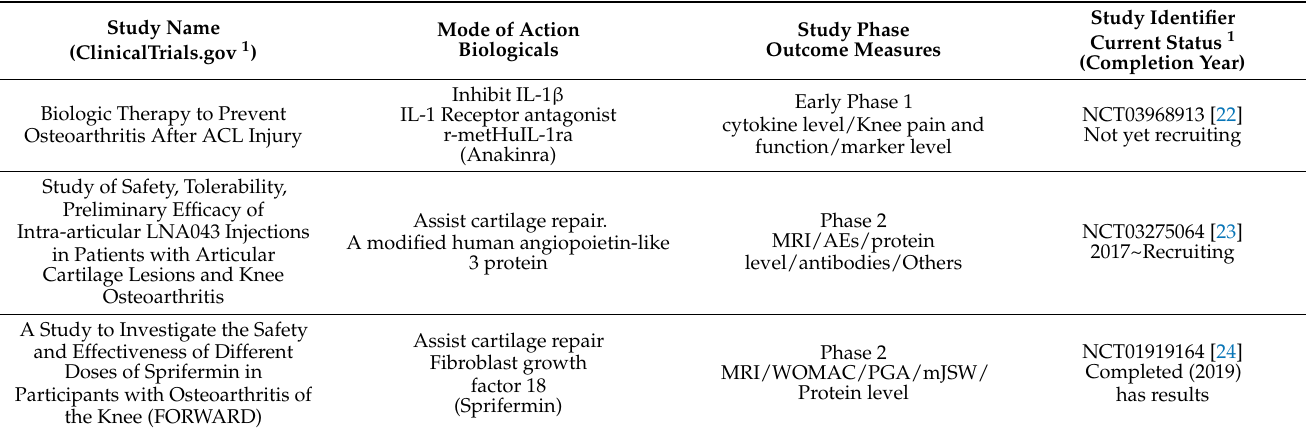
Table 1. Clinical trials of intra-articular (IA) injection of recombinant protein for osteoarthritis (OA) patients. Study Name (ClinicalTrials.gov 1